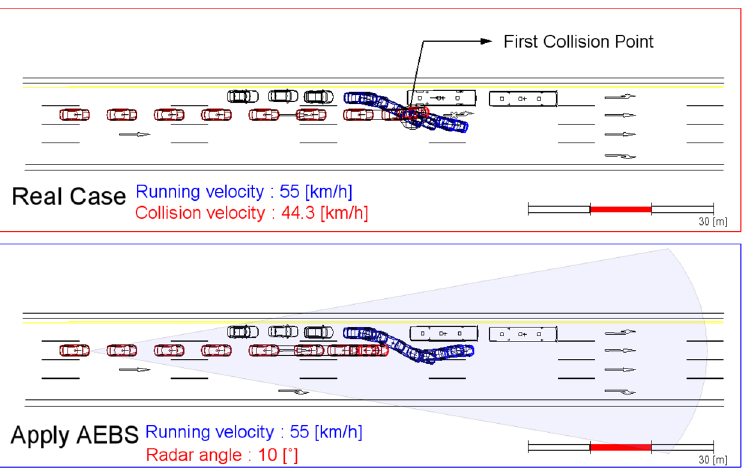
Figure 15. Real Case 3 application of the AEBS.